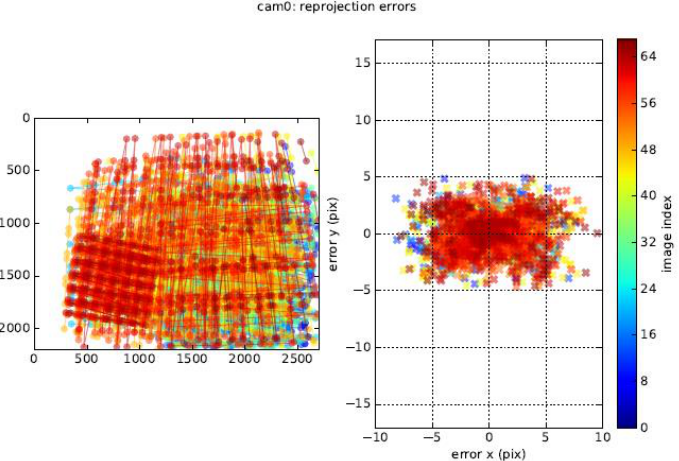
Figure 28. Reprojection error.